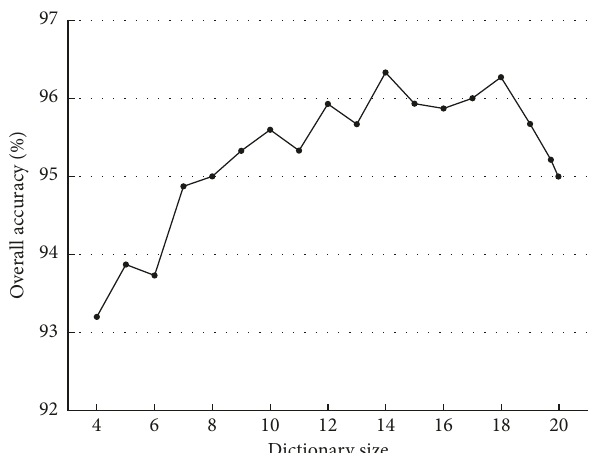
Figure 4: The overall accuracy on the updated dictionary with different sizes.